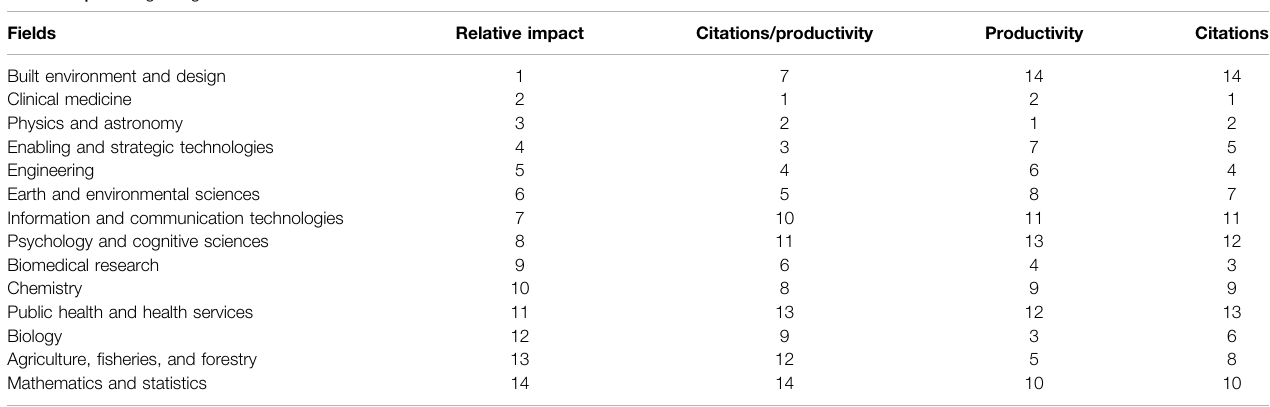
TABLE 6 | Ranking using diverse scientometric